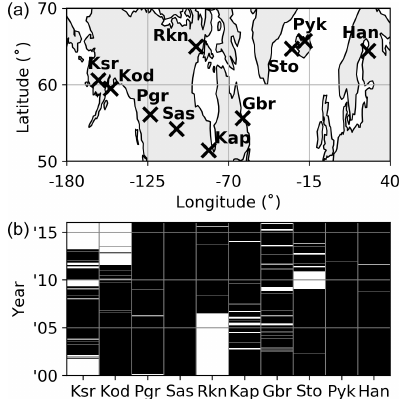
Figure 1. Abbreviated names and geographic locations (a) and time of operation between the years 2000 and 2016 (black marking b ) of the SuperDARN radars used in this